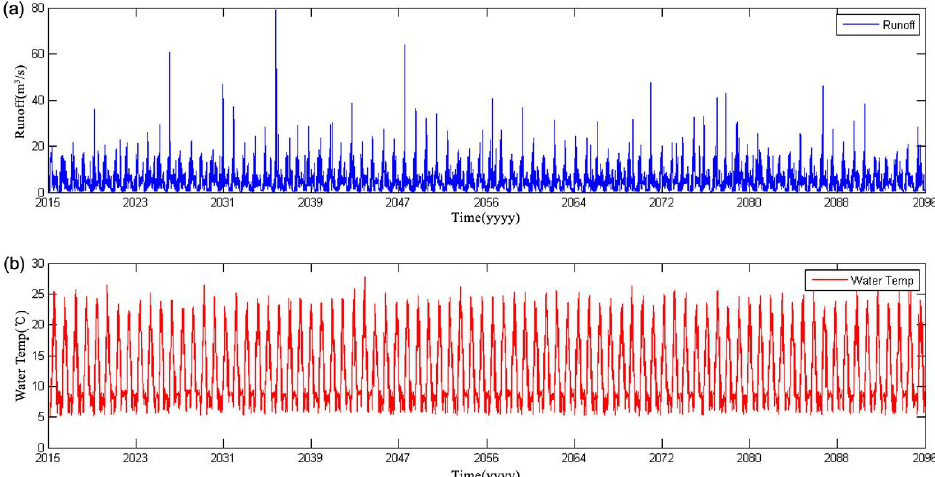
Figure 8. Simulated result of runoff and water temperature based on MPI-ESM-LR climate model with RCP 2.6.